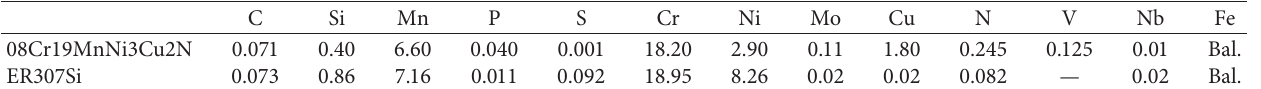
Table 2: Chemical compositions of base metal and filler metal (wt.%).